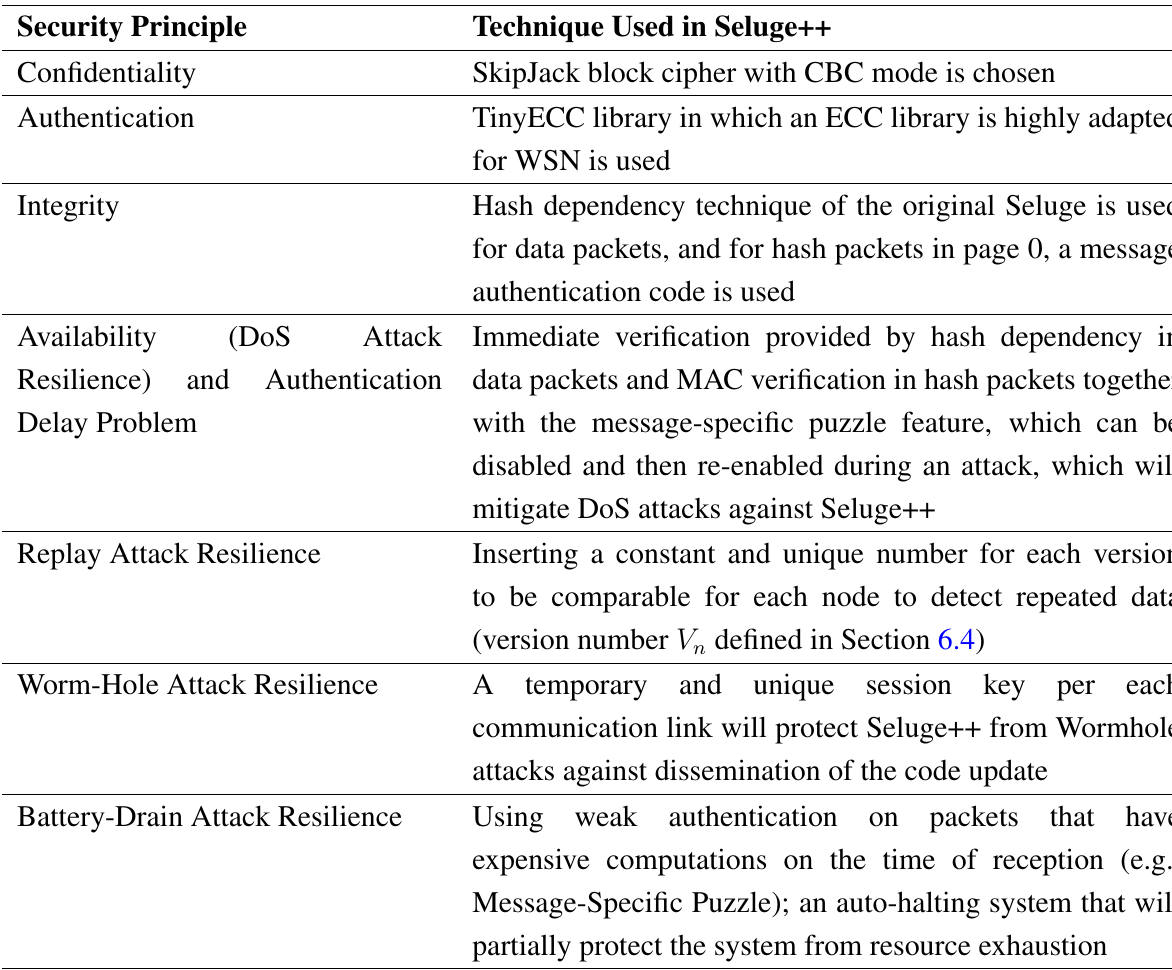
Table 7. Security features of Seluge++. CBC, cipher-block